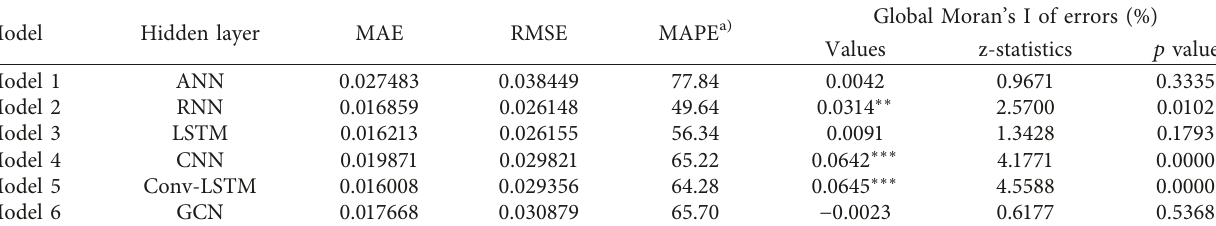
Table 2: Performance comparison of the